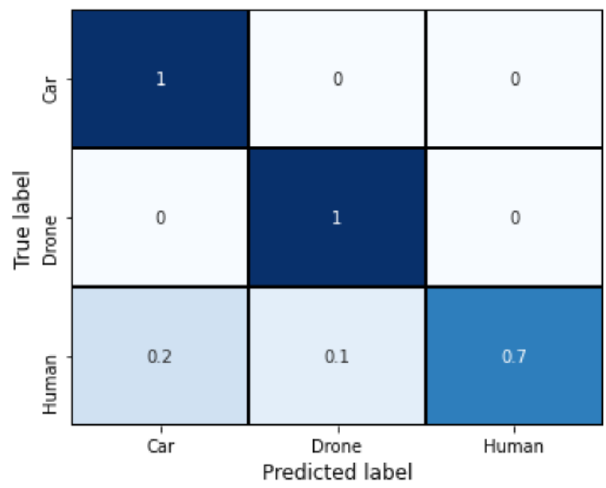
Figure 15. Confusion matrix of SVM model on test